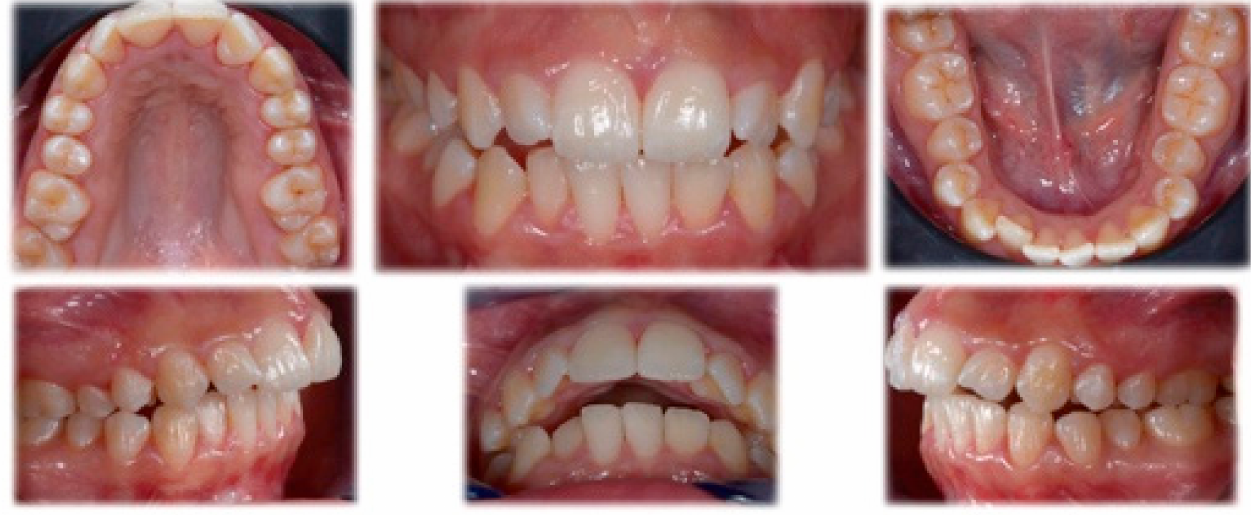
Figure 2. Pre-treatment intraoral records and X-rays showing full-cusp Class II molar and canine relationship on the right side, Class I molar and end-on canine relationship on the left side, with increased overjet and slight open-bite on the lateral